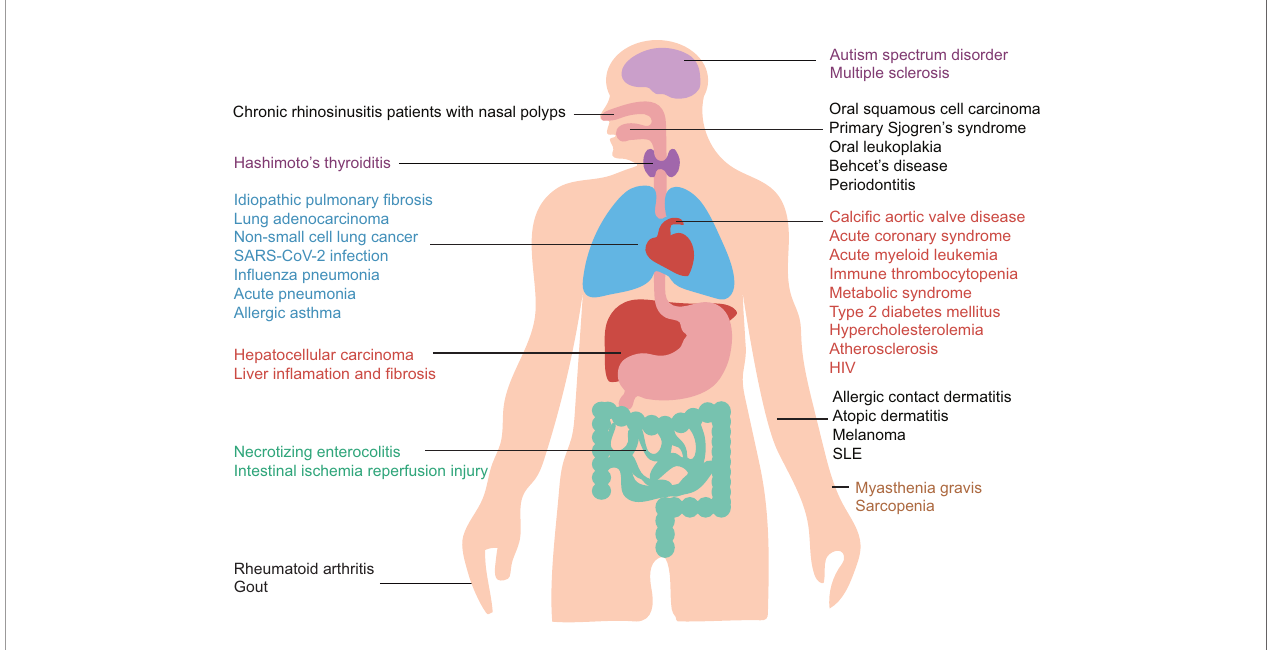
FIGURE 1 | Potential roles of IL-37 in human health and disease. IL-37 exerts a wide range of protective effects in several different diseases. Moreover, IL-37 may be used as a biomarker for in fl ammatory diseases, autoimmune diseases, and cancer due to the abnormal levels of IL-37 in patients affected by these